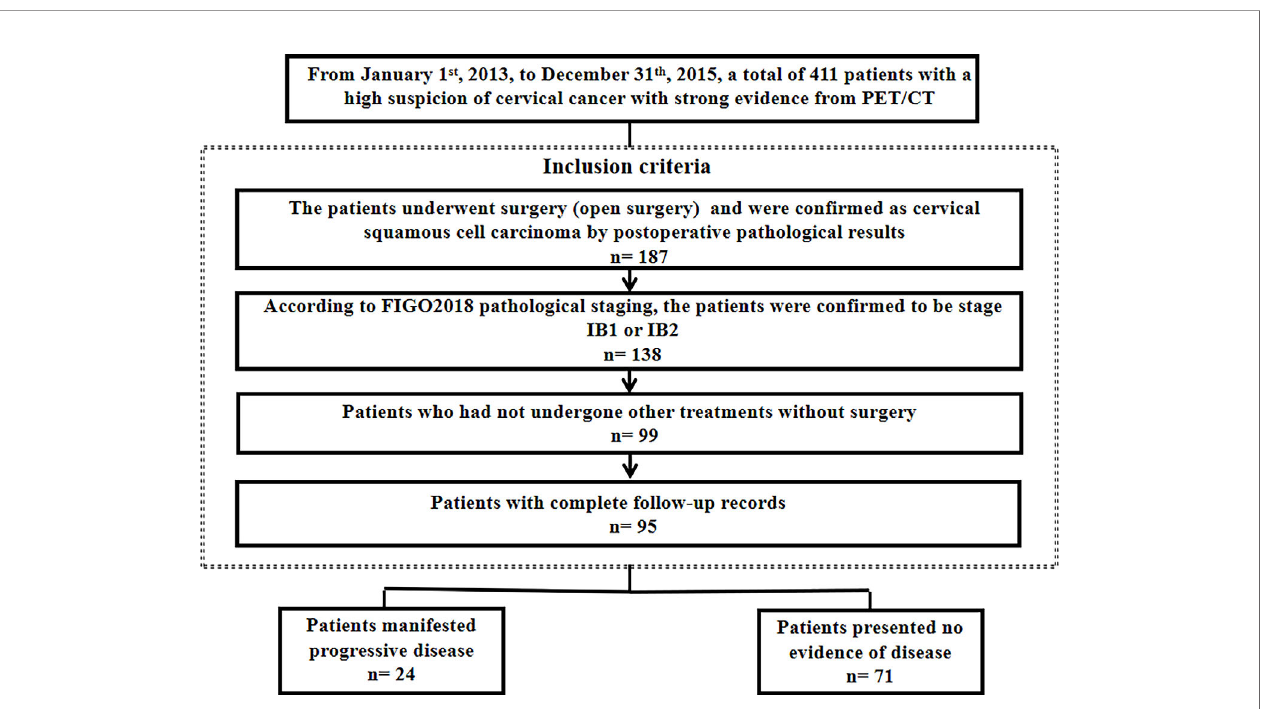
FIGURE 1 | Patient